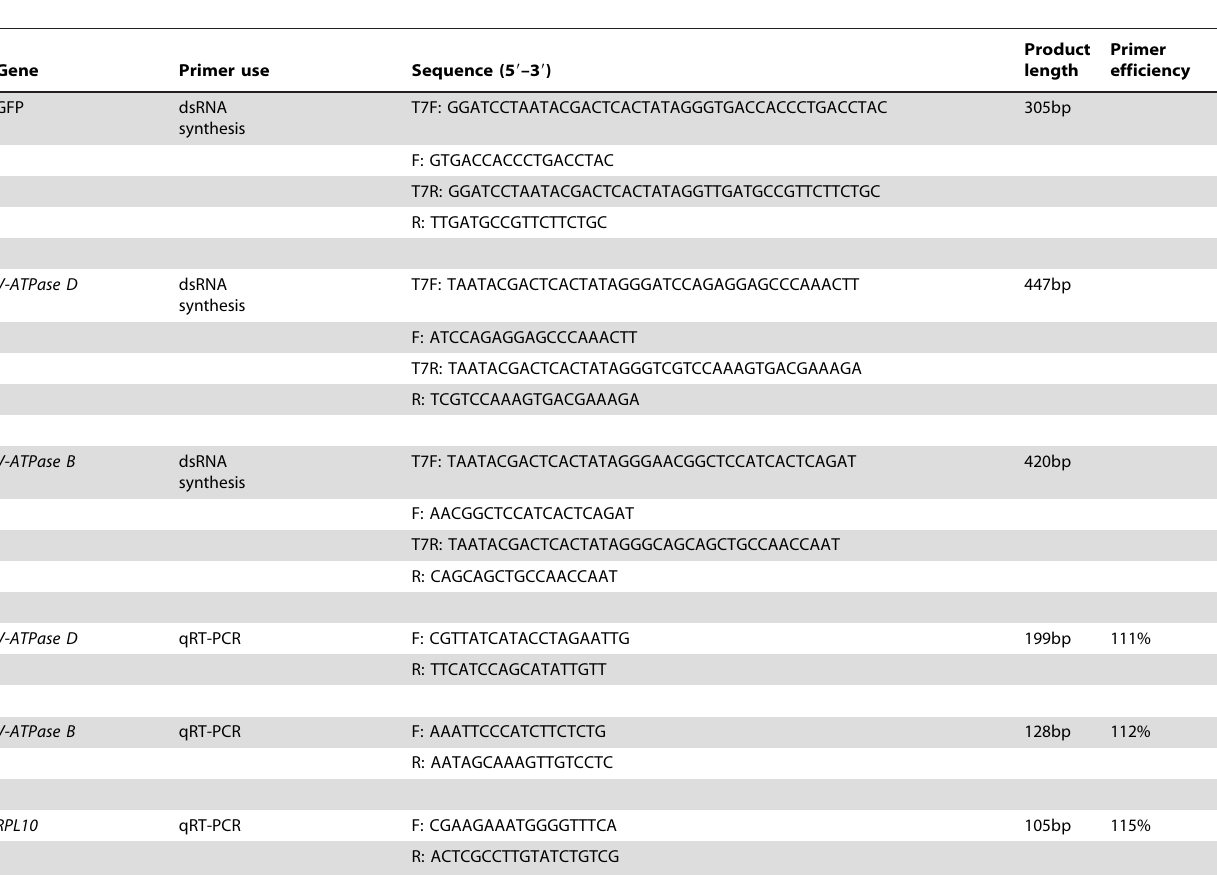
Table 1. Primer sequences used for dsRNA synthesis and real-time quantitative reverse transcriptase-PCR (qRT-PCR).